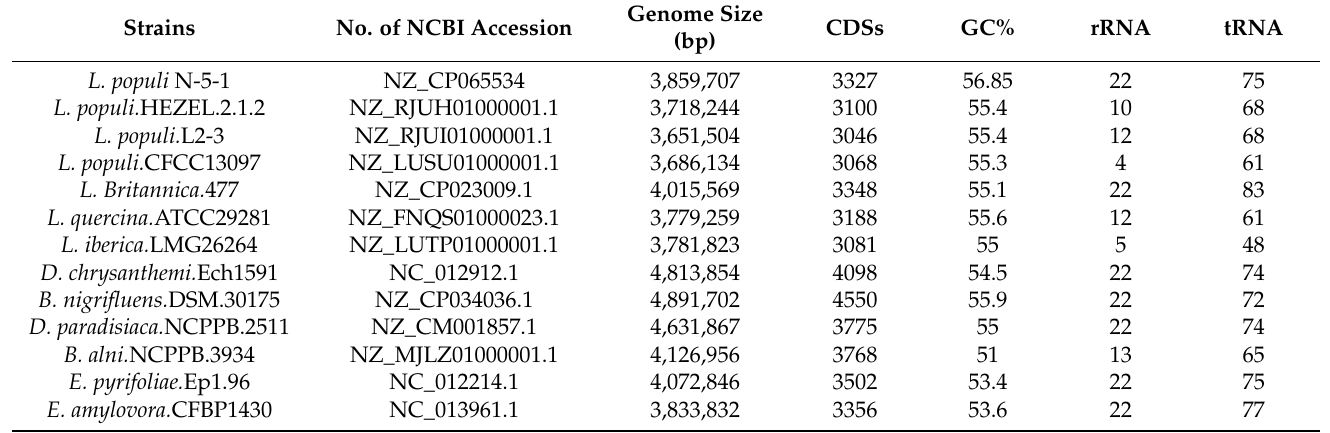
Table 3. General genome characters of the 12 associated strains used in this study.